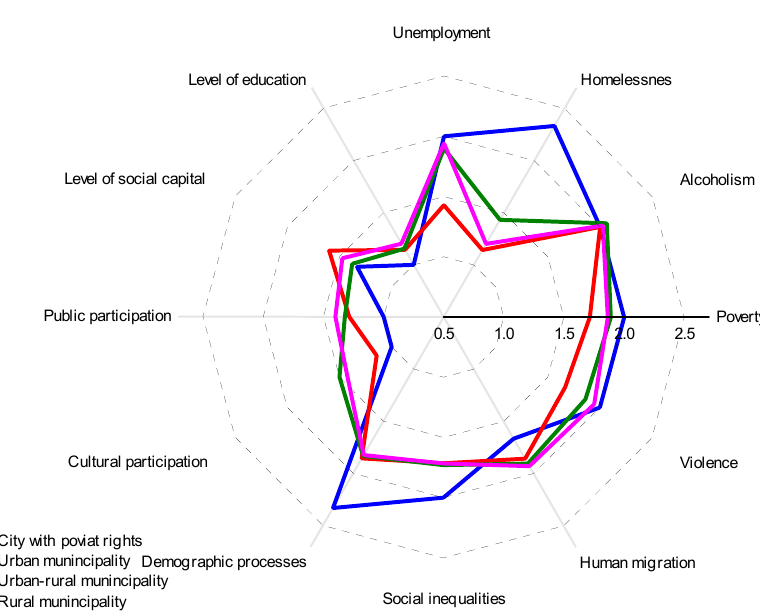
Figure 3. The prevalence of selected social problems in the analysed municipalities depending on the type of municipality.